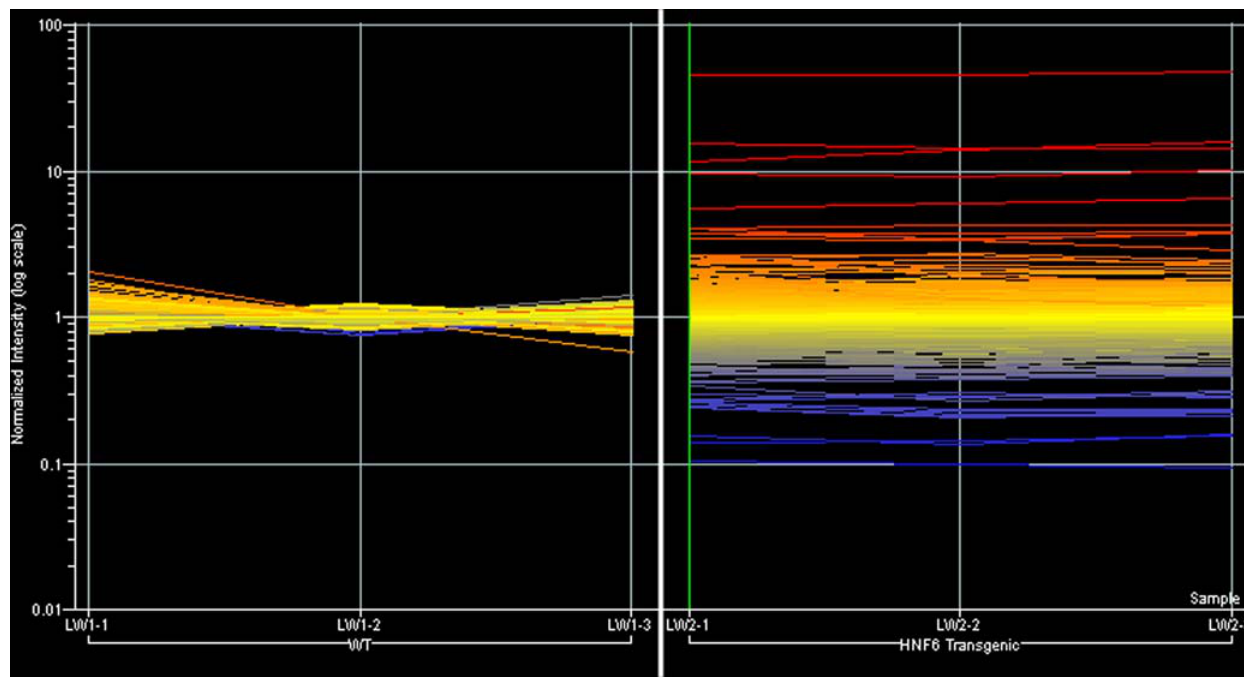
Figure 2. Assessment of replicate consistency and gene expression changes. Each line on the graph represents an individual spot on the array. Normalized ratio values of the average for the three WT samples (WT1-WT3) were plotted against each individual WT sample (left) and each individual Hnf6 Tg sample (right; Tg1-Tg3). Ratio values indicating no change in gene expression are seen in yellow at a value of 1.0. Transcripts that have an altered expression in Hnf6 Tg animals compared to WT animals are indicated in shades of red (greater than 1.0) or blue (less than